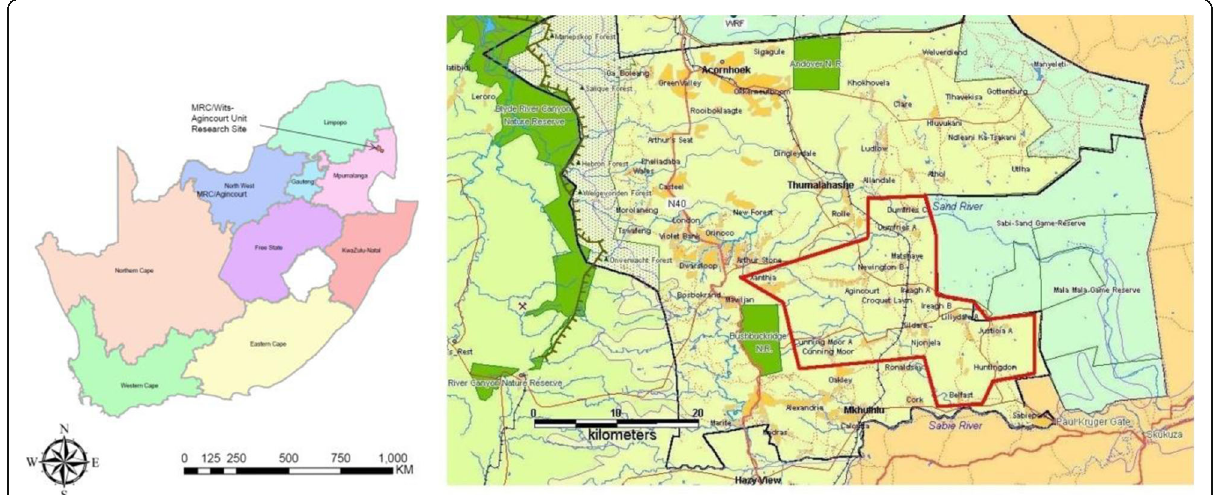
Fig. 1 Agincourt HDSS study area in South Africa and details of the HDSS site in 2007. Source: adapted from Freeman, P.H 2002